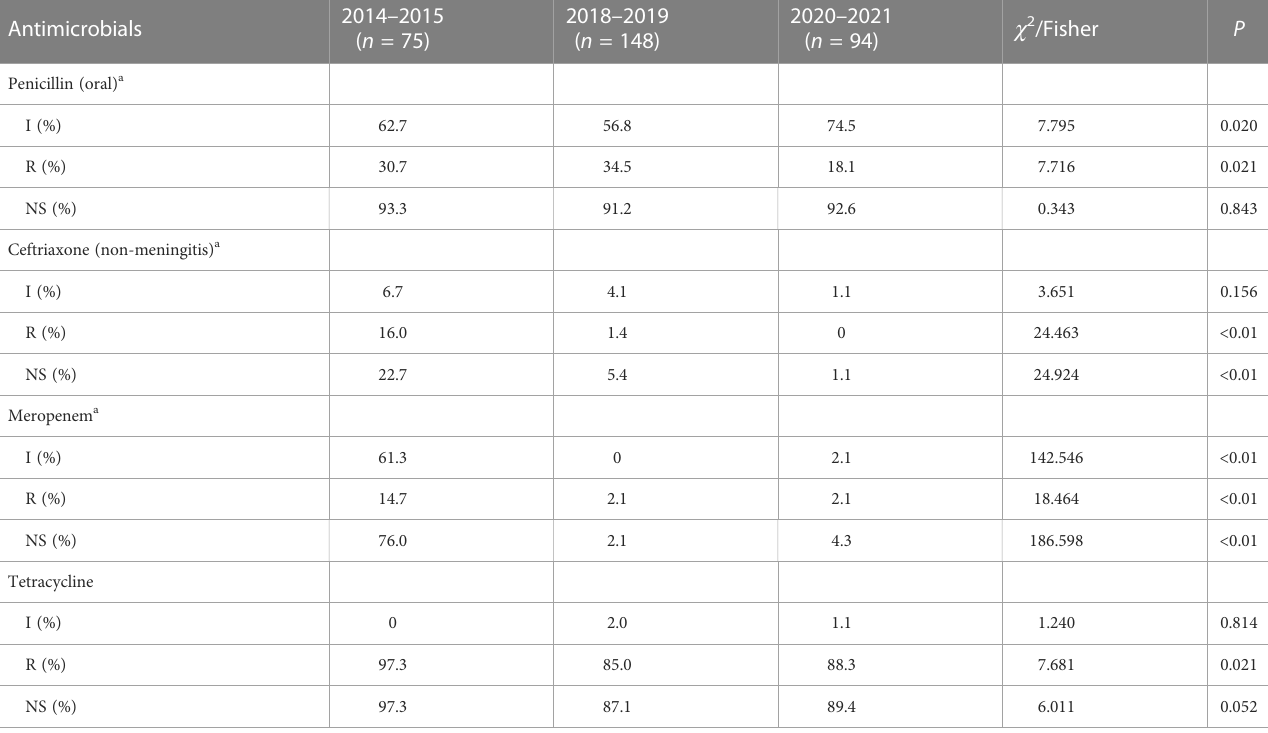
TABLE 5 Comparison of the susceptibility of S. pneumoniae to penicillin (oral) and ceftriaxone (non-meningitis) between different years.